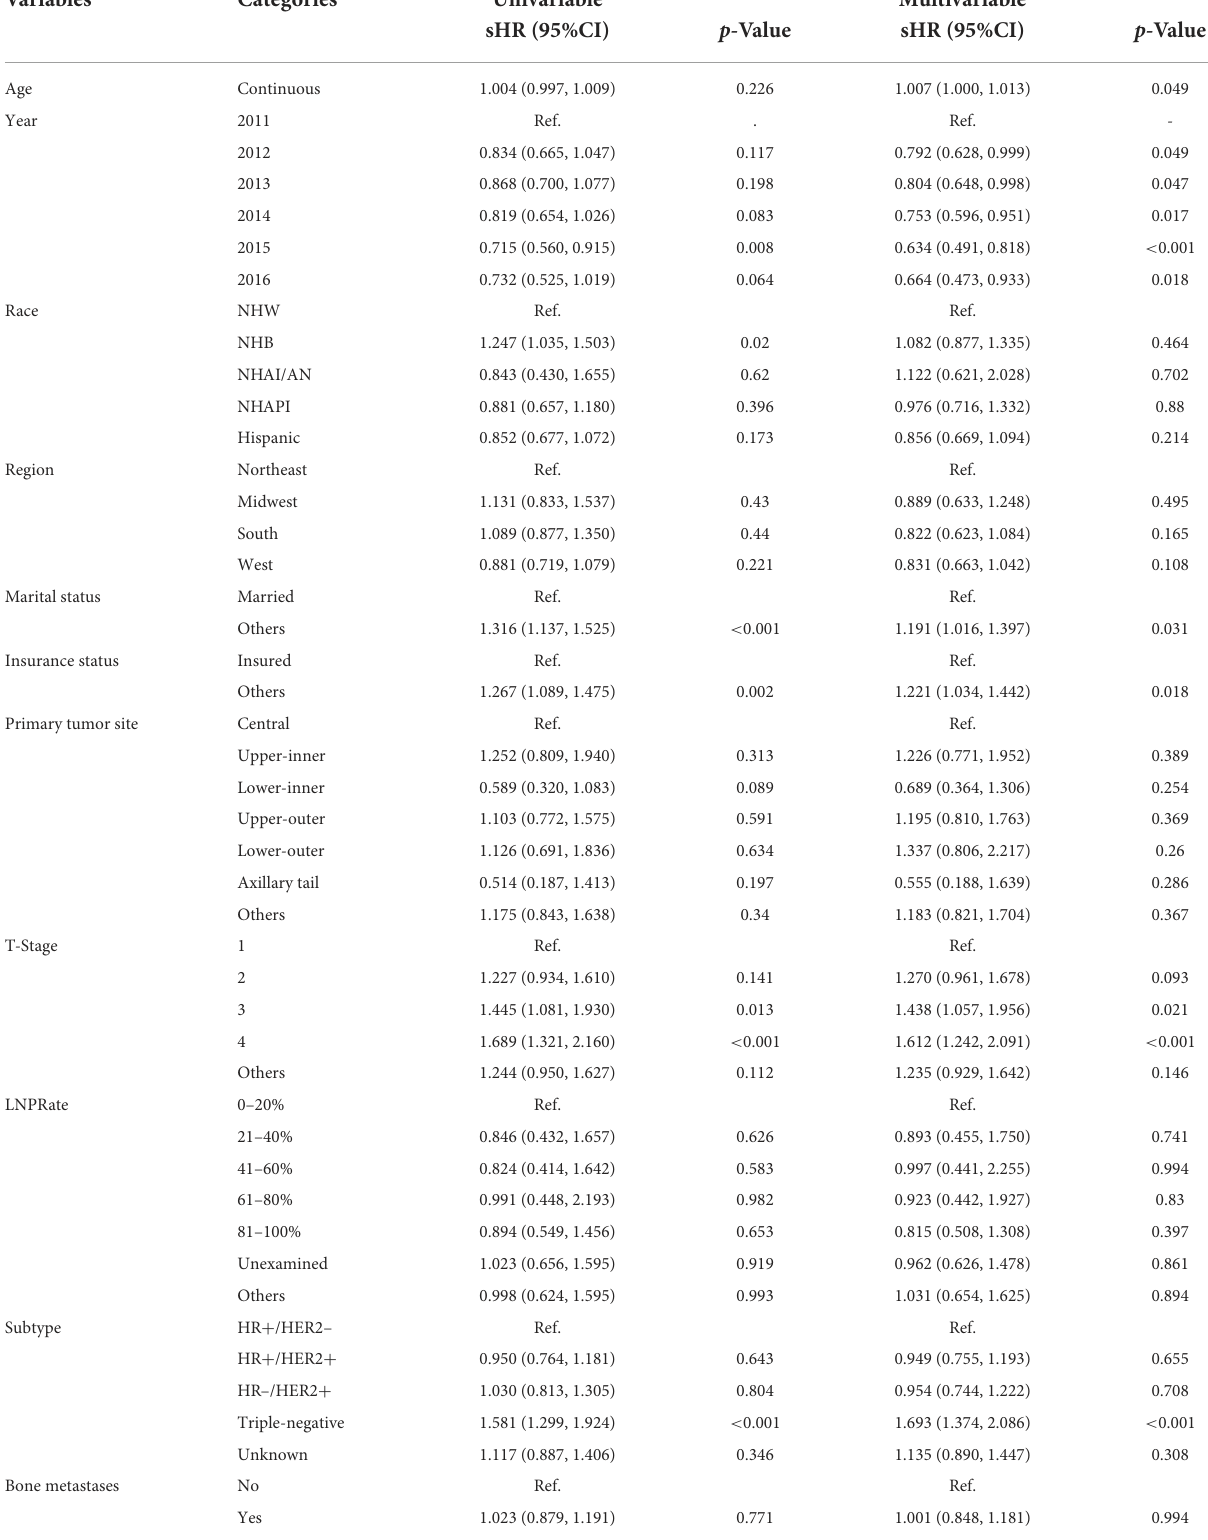
TABLE 5 Proportional subdistribution hazards models for breast cancer synchronous brain